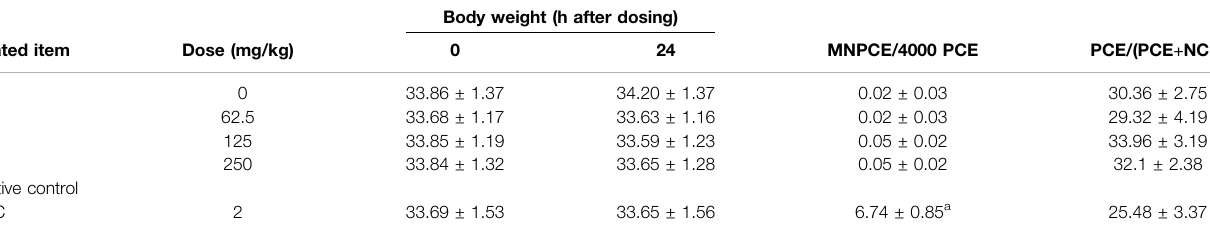
TABLE 8 | In vivo micronucleus test.